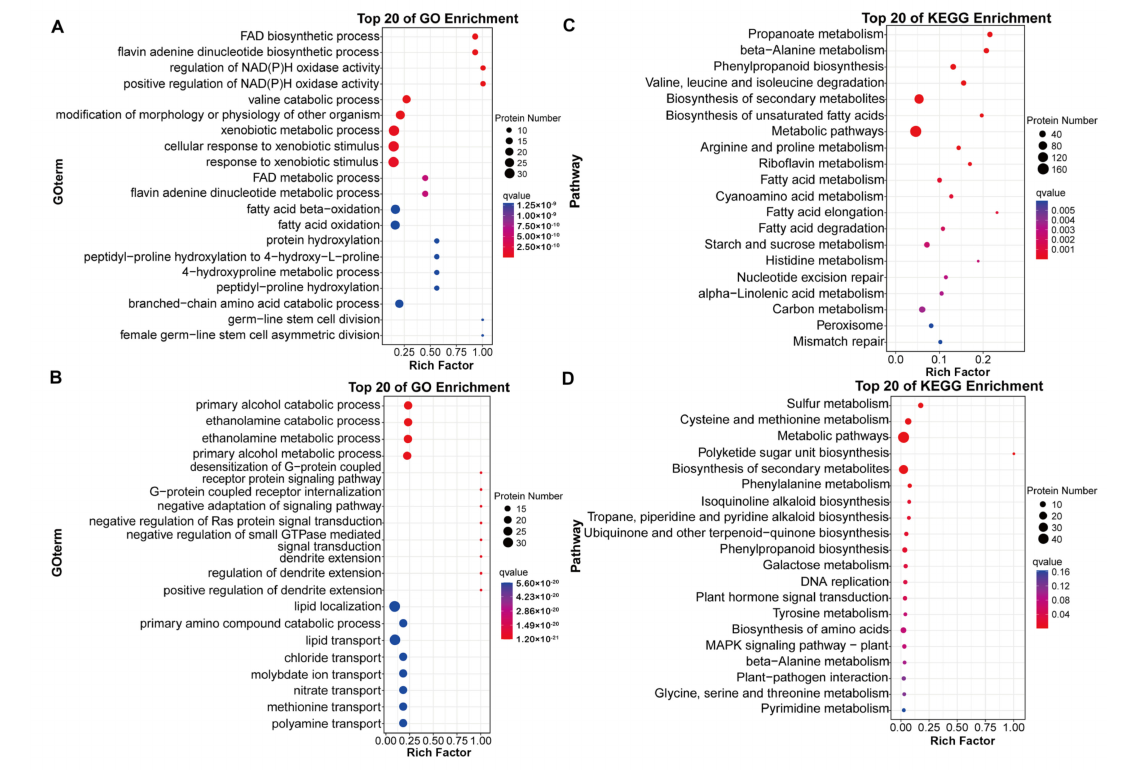
Figure 3. GO enrichment and KEGG pathway enrichment analysis of DEPs in GN2 and GN18 under salt stress at 24 h. Top 20 GO terms of the enriched scatter plot of DEPs in the salt response during the seed germination of ( A ) GN2 and ( B ) GN18. Top 20 KEGG pathways of the enriched scatter plot of DEPs in the salt response during the seed germination of ( C ) GN2 and ( D )